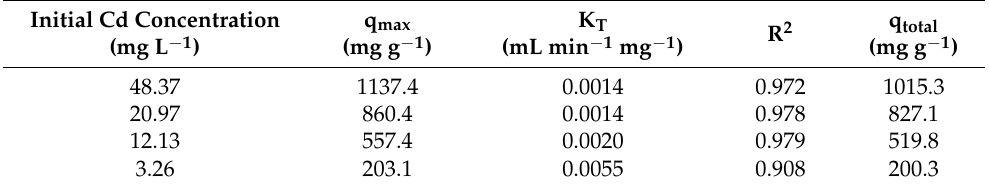
Table 2. The Thomas model parameters in a fixed-bed column packed with iminodiacetic resin that were found at different initial concentrations of cadmium in the GSH solution. The experimental conditions were a pH of 6.2, a flow rate of 140 mL min − 1 , and a temperature of 55 ◦ C. Initial Cd